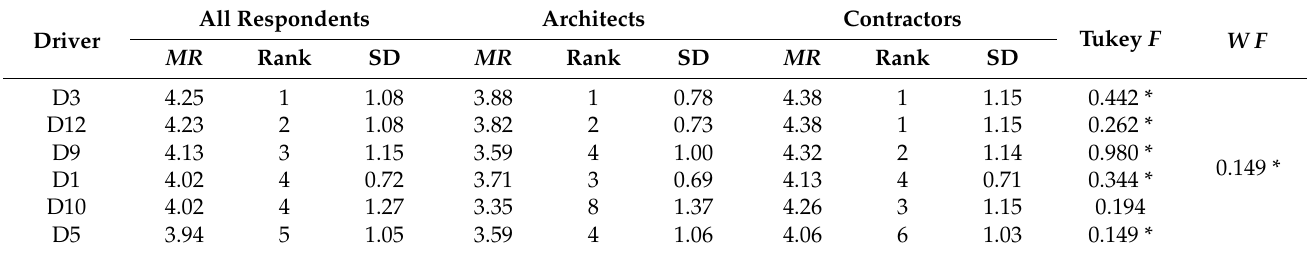
Table 3. Mean ratings, ranking, pairwise, and inter-group comparisons of the significance of the differences in ranks for key drivers for BIM